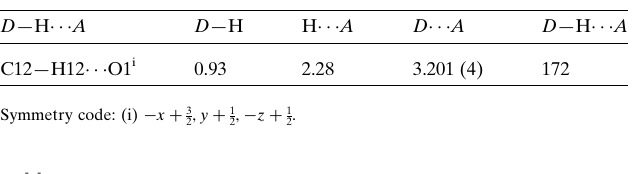
Table 2 Experimental details.